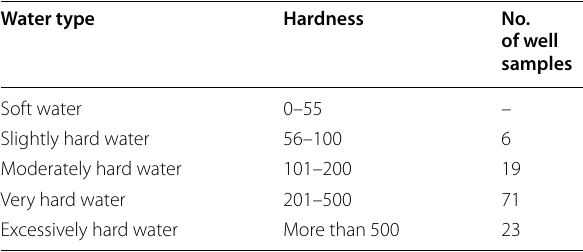
Table 4 Classification of the water according to degrees of hardness in the studied